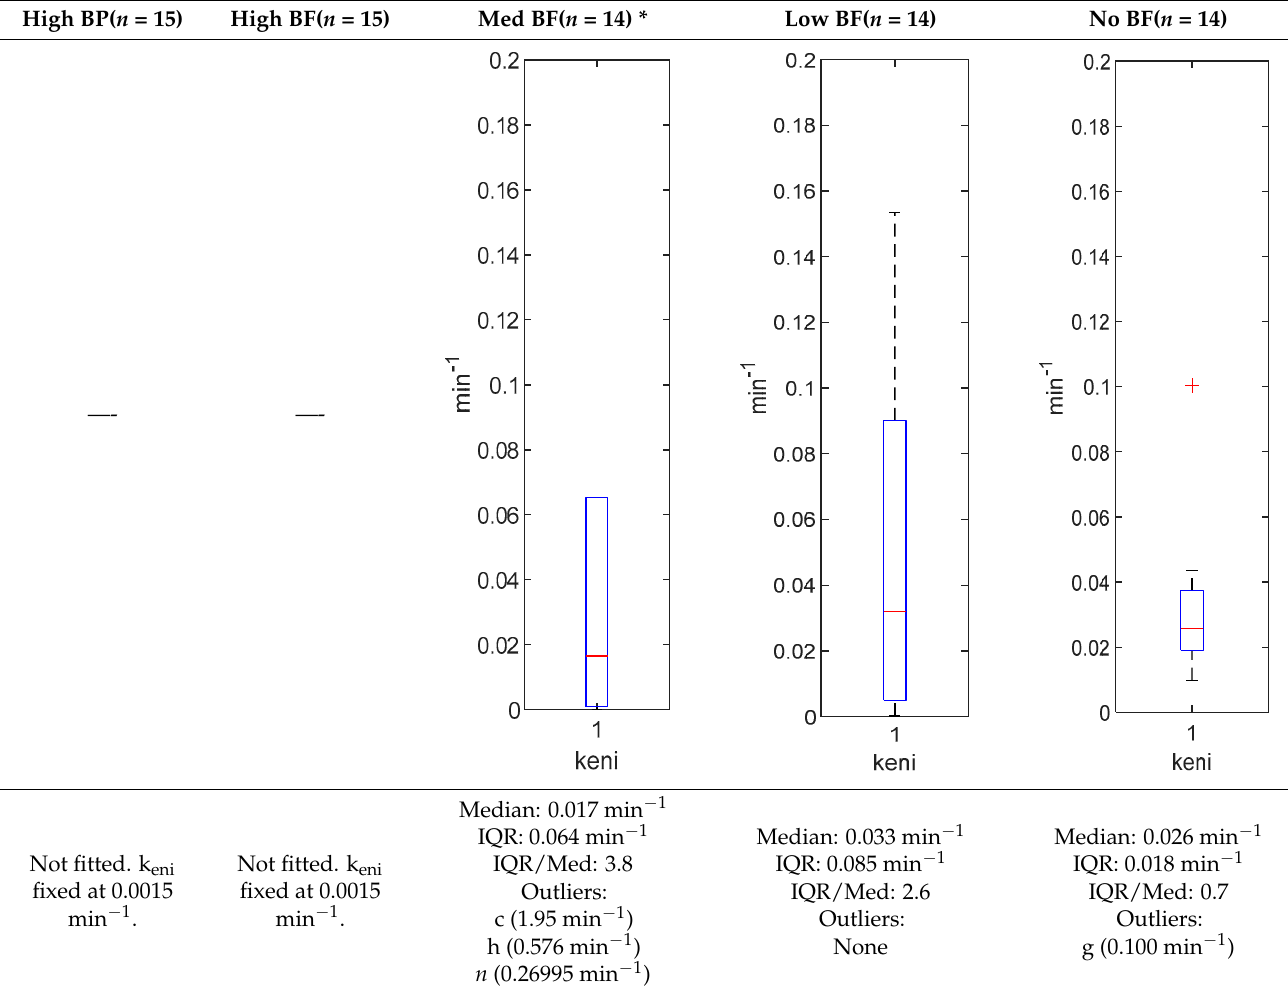
Table 6. k eni estimation results (horizontal red bar: median, blue box second and third quartile, whiskers first and fourth quartiles, +: outliers).